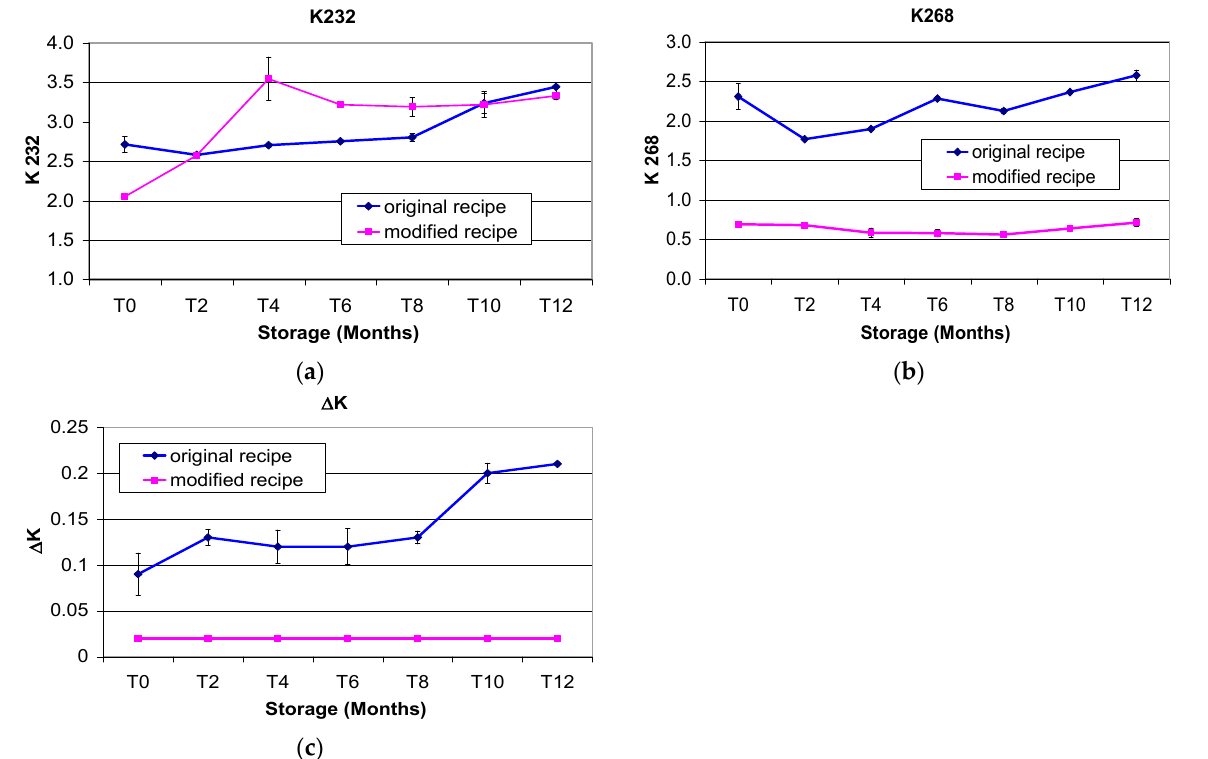
Figure 5. ( a ) K232 values for fat samples extracted from Italian Cantuccini biscuits prepared from the original recipe and the modified recipe during one year’s shelf-life. ( b ) K268 values for fat samples extracted from Italian Cantuccini biscuits prepared from the original recipe and the modified recipe during one year’s shelf-life; ( c ) The ∆ K values for fat samples extracted from Italian Cantuccini biscuits prepared from the original recipe and the modified recipe during one year’s shelf-life.